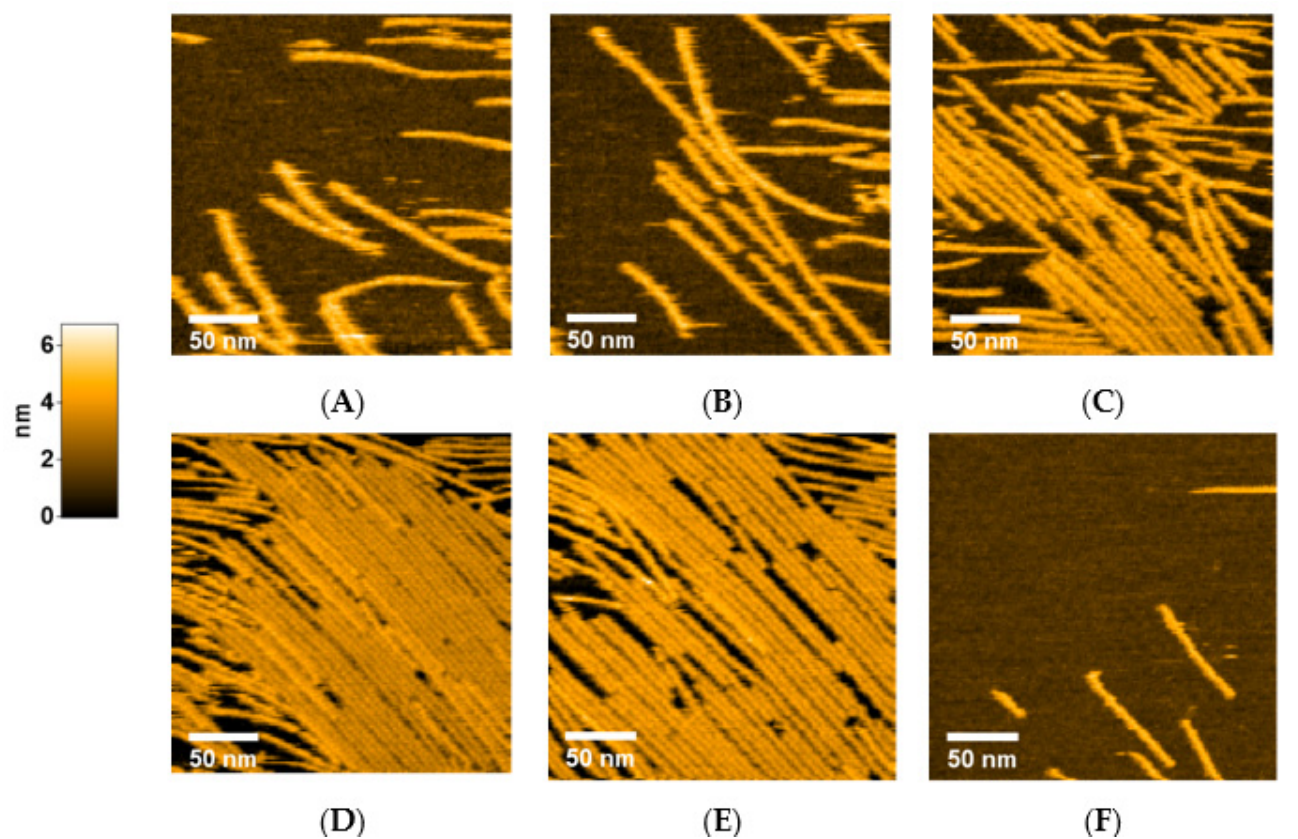
Figure 2. Growth and dissociation of FtsZt filaments. Each image was taken under the following conditions: ( A ) 100 nM FtsZt and 300 μ M GTP; ( B ) 100 nM FtsZt and 600 μ M GTP; ( C ) 200 nM FtsZt and 600 μ M GTP; ( D ) After 20 min incubation from ( C ); ( E ) 200 nM FtsZt, 600 μ M GTP, and 3 mM GDP; ( F ) 200 nM FtsZt, 600 μ M GTP, and 6 mM GDP. Scale bar: 50 nm.